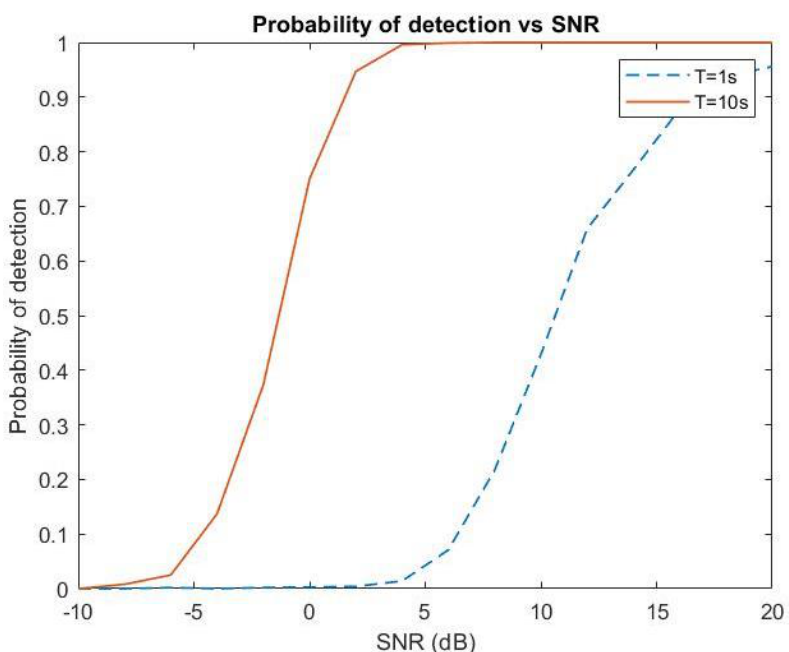
Figure 6. Detection probability curve with 10% False